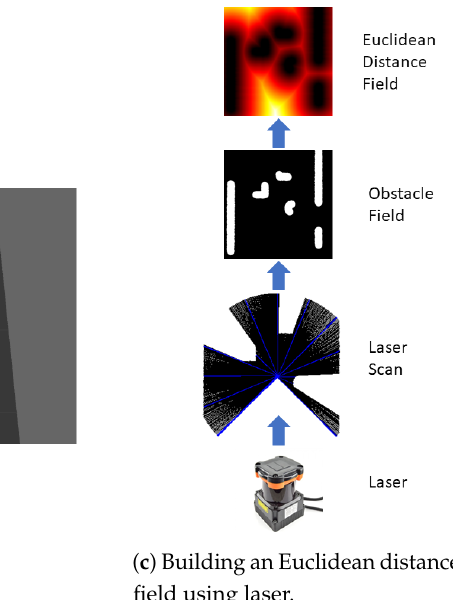
Figure 1. The real flight environment and the aerial robot used in the real flight experiments. On the left of this figure is the workflow for calculating the Euclidean distance field. First, building the obstacle field from the depth image, and then constructing the Euclidean distance field based on the obstacle field.